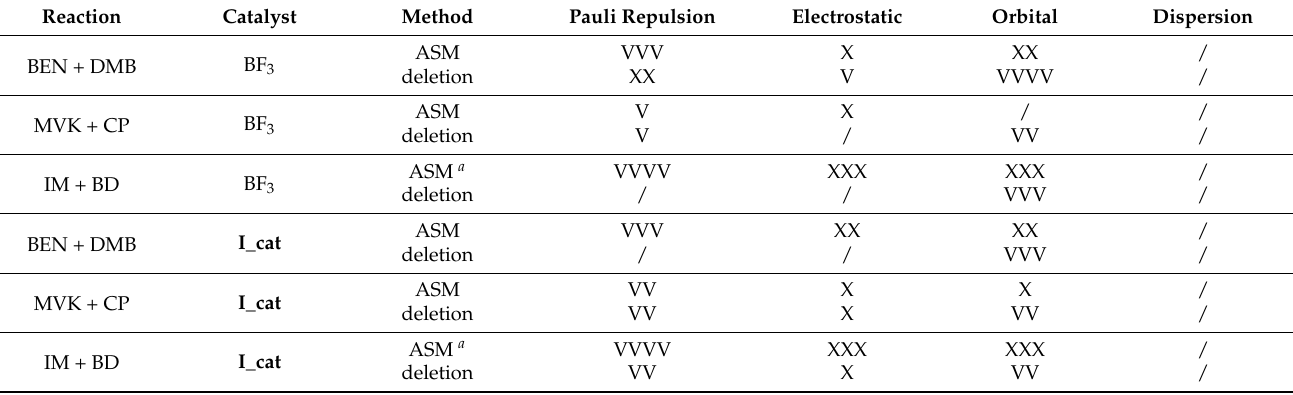
Table 6. Summary of the importance of the different interaction energy components using the activation strain model (ASM), combined with EDA, and the catalyst-deletion approach. V indicates a positive contribution to the catalyst-induced stabilization of the transition state whereas X denotes a negative